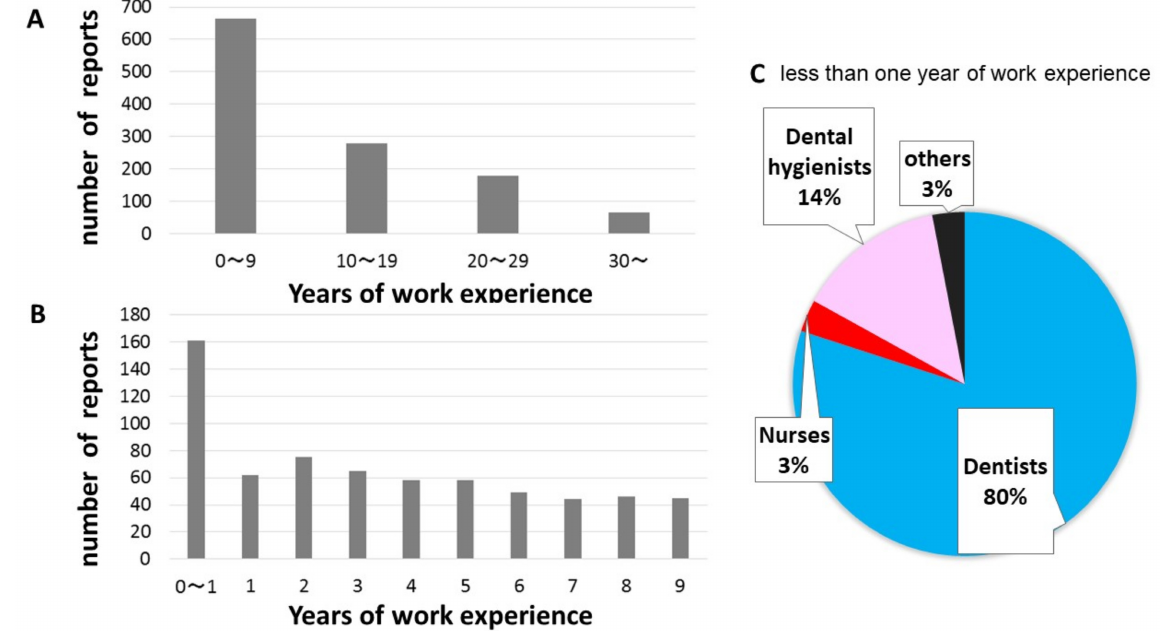
Figure 3. ( A ) Relationship between years of work experience every 10 years and number of incident reports. ( B ) Comparison of the number of reports from subjects with 0 to 9 years of work experience. ( C ) Report rate by occupation among dental care workers with less than one year of work experience.